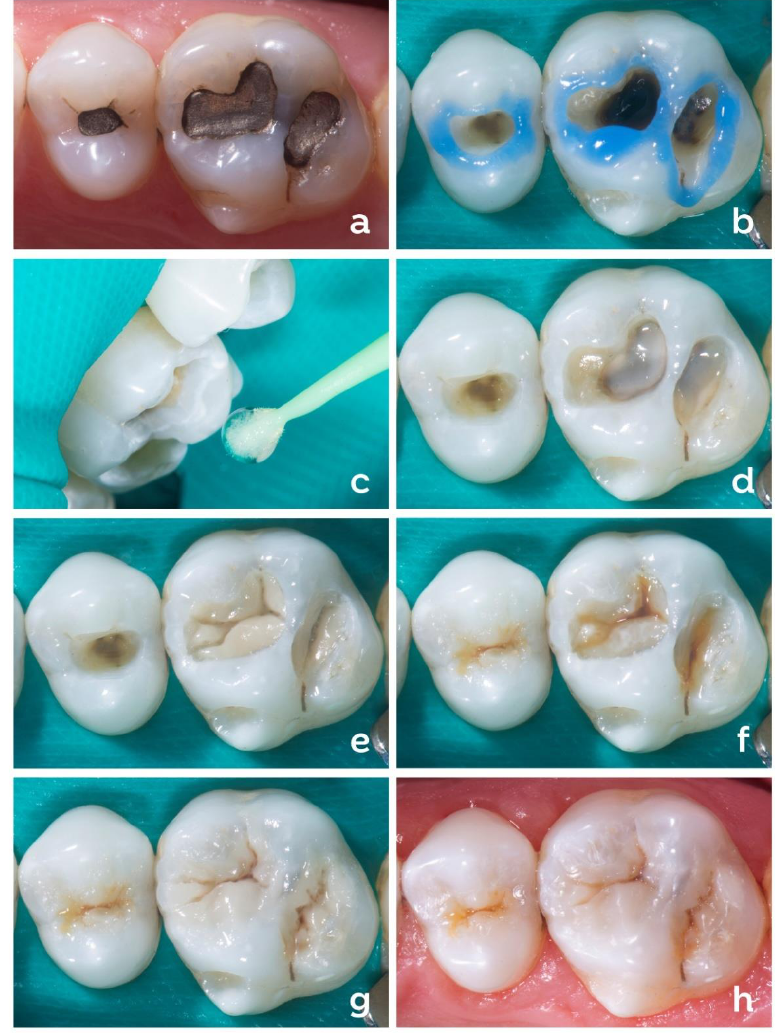
Figure 4. Initial aspect of an amalgam restoration to be replaced ( a ). Selective enamel etching with phosphoric acid ( b ). Application of self-etch adhesive system ( c ). A thin layer of opacifier is applied on darkened dentin ( d ). Insertion of dentin composite and design of occlusal map ( e ). Ochre, brown, and white tints applied to increase three-dimensionality ( f ). Enamel composite inserted using a single increment ( g ). Immediate final aspect of the restoration after removal of rubber dam and occlusal adjustment ( h ).